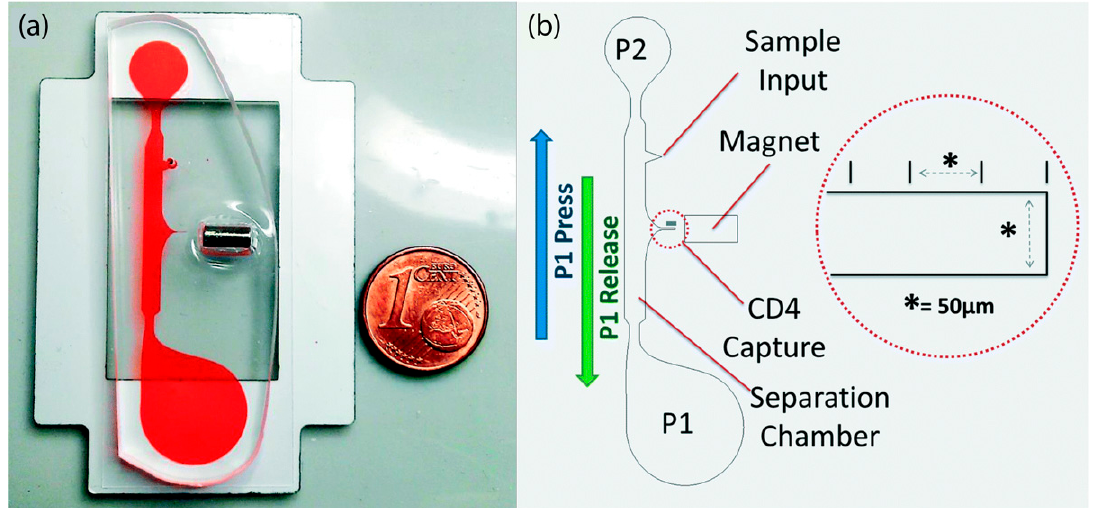
Figure 5. Finger-press-operated magnetophoretic cell separator for CD4+ isolation. ( a ) Image of the microfluidic chip with an embedded permanent magnet. ( b ) Schematic of the components. Reproduced with permission [63]. Copyright 2014 RSC.